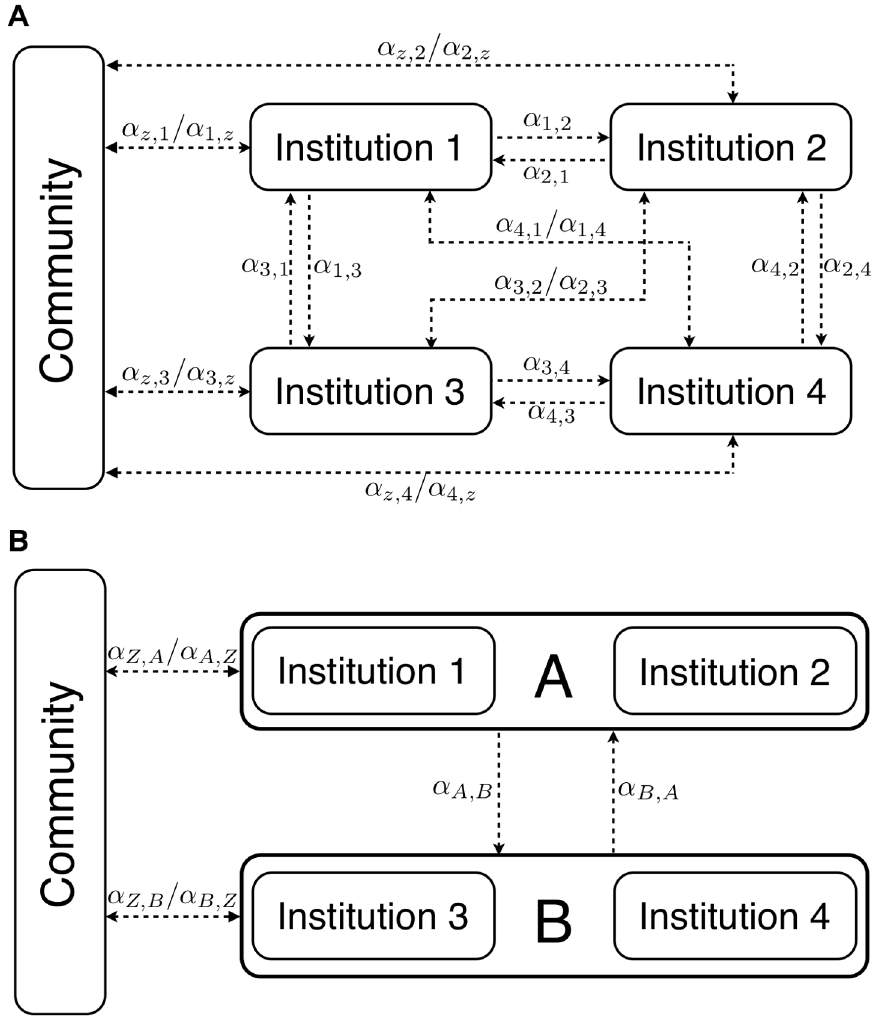
Figure 1. Model of patient flow. In Figure A, the direction of patient movement between various health institutions and the community, along with the associated flow parameters, are depicted in a setting with four institutions. In Figure B, these institutions have been clustered into two DUs, and the flow parameters between the DUs and the community are shown. Comparing Figure A to Figure B illustrates how patient movement between institutions becomes internalized into the flow parameters depicted in equation 6 when institutions are clustered into a focal DU and second DU.